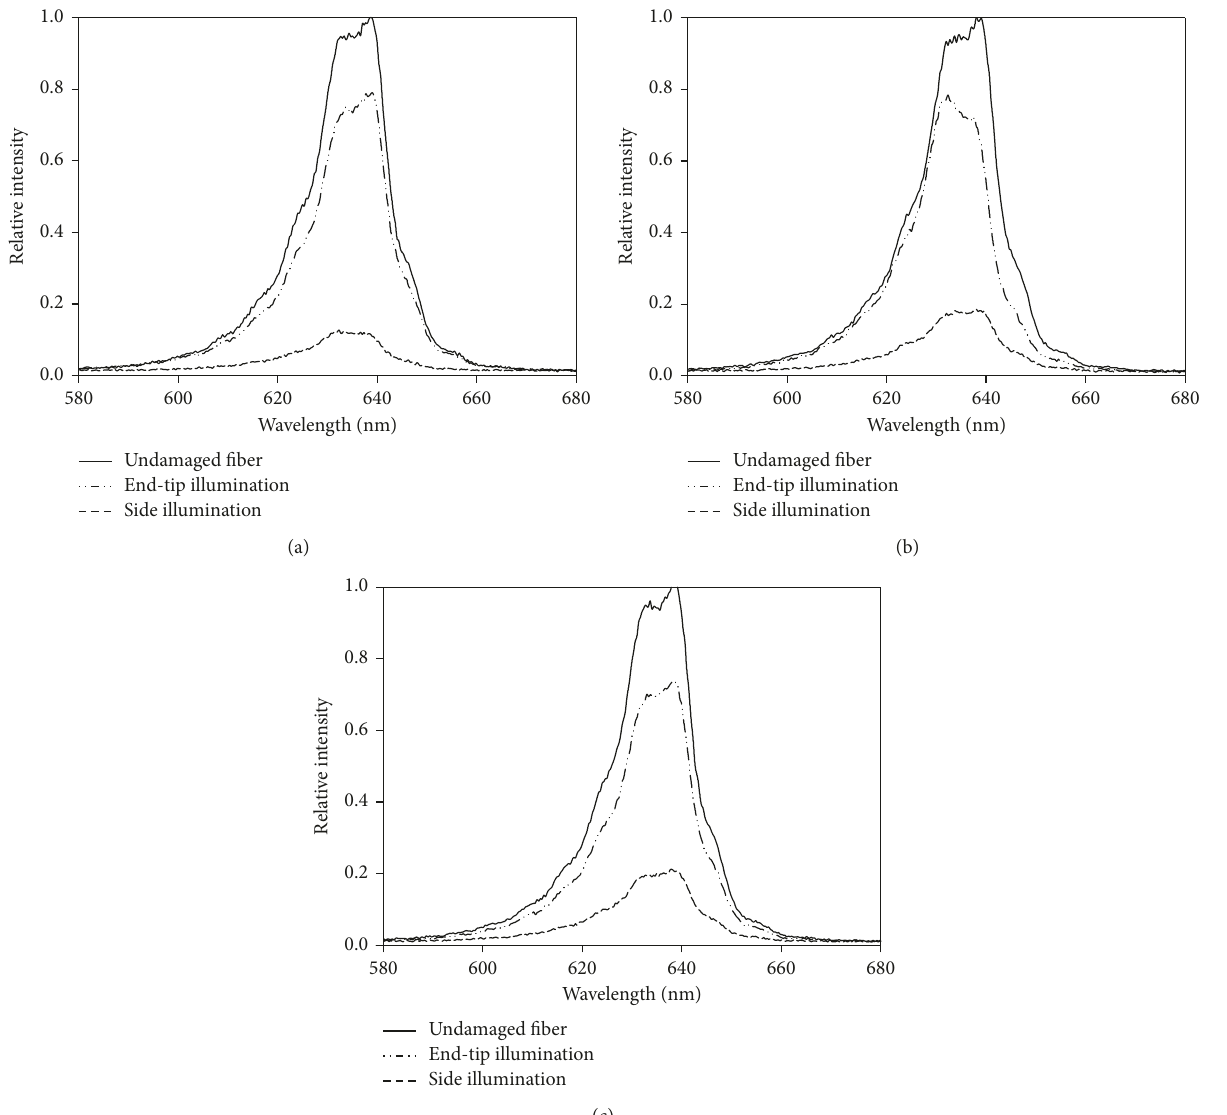
Figure 18: Comparison of side illumination and end-tip illumination for the three POF specimens. (a) PGR-FB250. (b) PGR-FB750. (c)